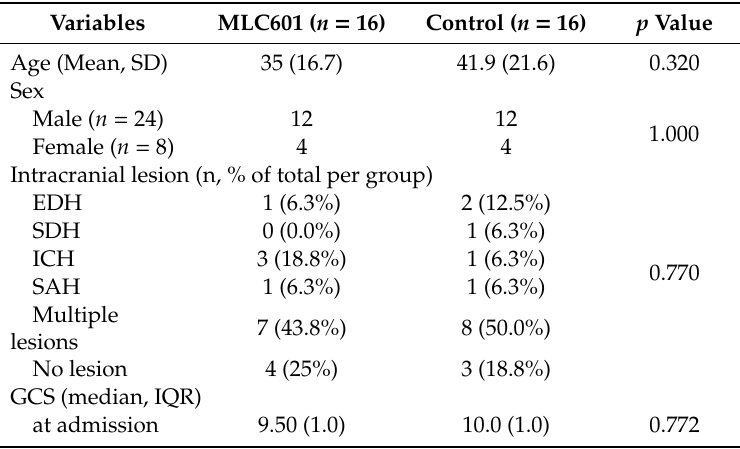
Table 1. Baseline characteristics.